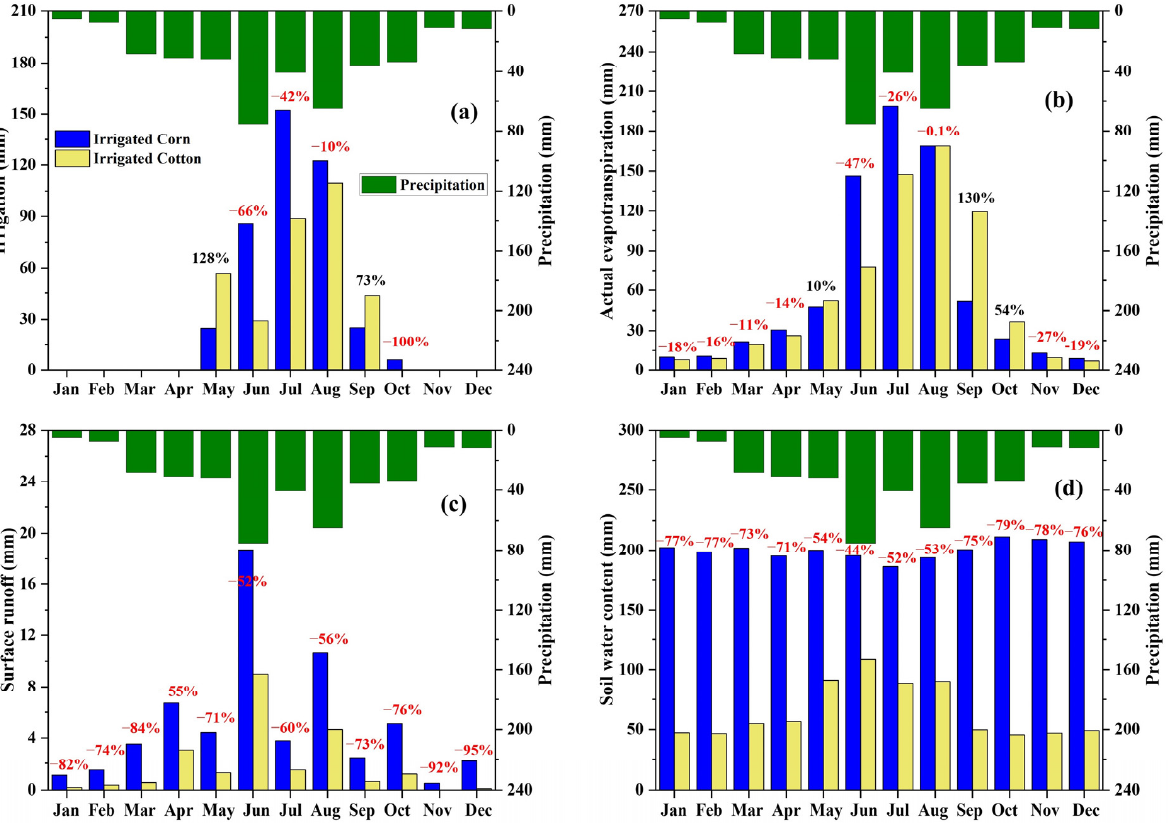
Figure 5. Monthly comparison of hydrologic parameters (mm) under the baseline irrigated corn and the land-use change scenario of irrigated cotton in the Palo Duro watershed. Irrigation ( a ), actual evapotranspiration ( b ), surface runoff ( c ), and soil water content ( d ).